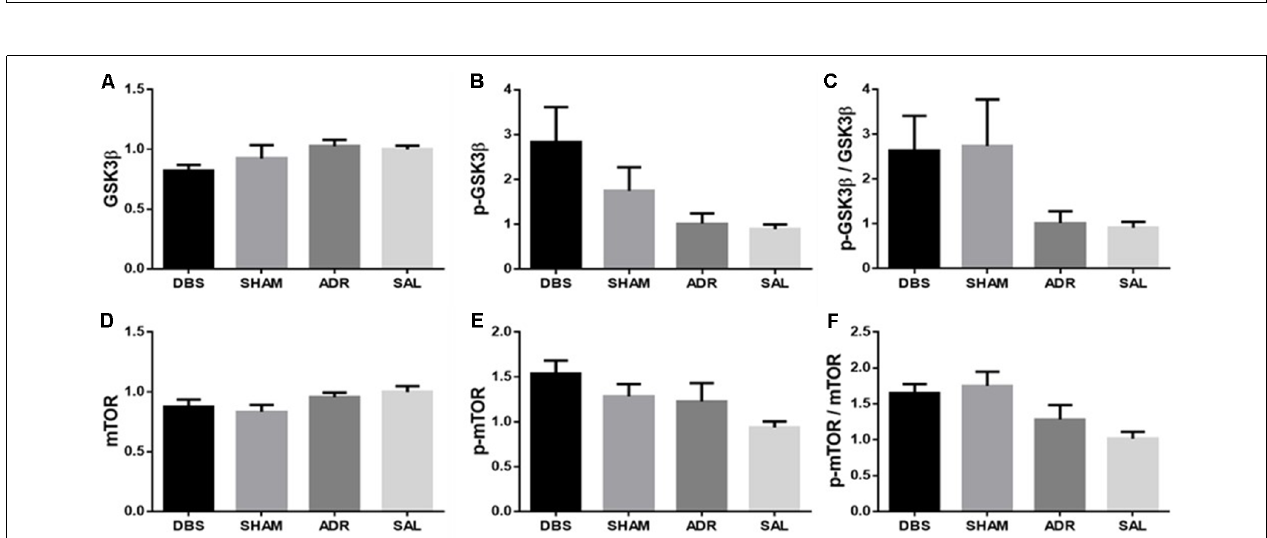
FIGURE 8 | dHipp protein expression levels of (A) GSK3 β , (B) p-GSK3 β , (C) p-GSK3 β /GSK3 β , (D) mTOR, (E) p-mTOR, (F) p-mTOR/mTOR. Data are shown as mean concentration standardized to β -actin and normalized to SAL controls for each gel ± standard error.